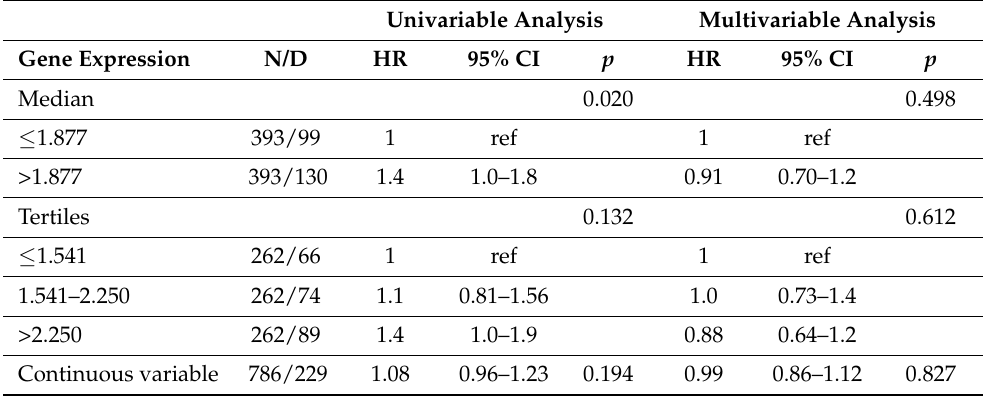
Table 10. Overall Survival of 786 NB patients in relation to CMPK2 expression levels evaluated by the Cox